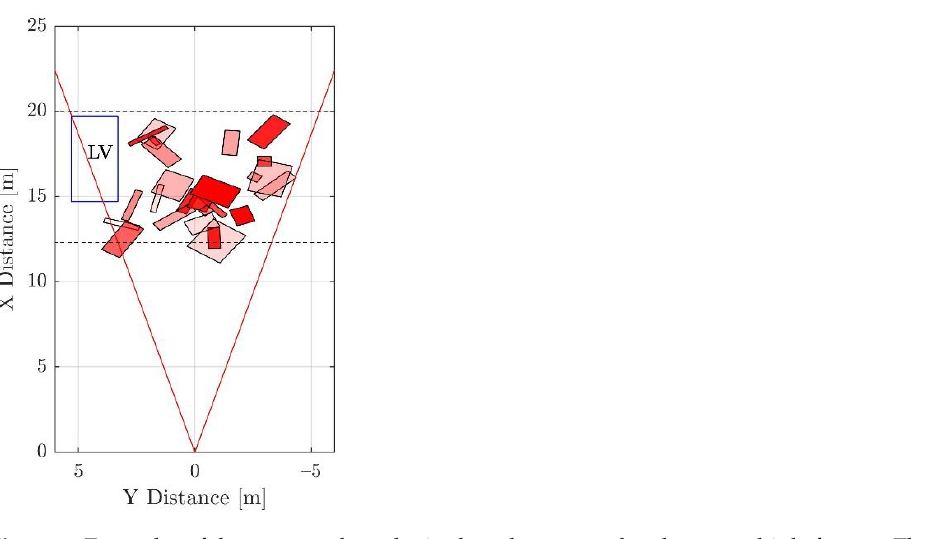
Figure 5. Examples of the generated synthetic obstacles accumulated over multiple frames. The red and dotted lines mark the ROI. The transparency of the box is proportional to its reflection value. The blue box marked ‘LV’ corresponds to the position of the leading vehicle and collisions with it are automatically removed.